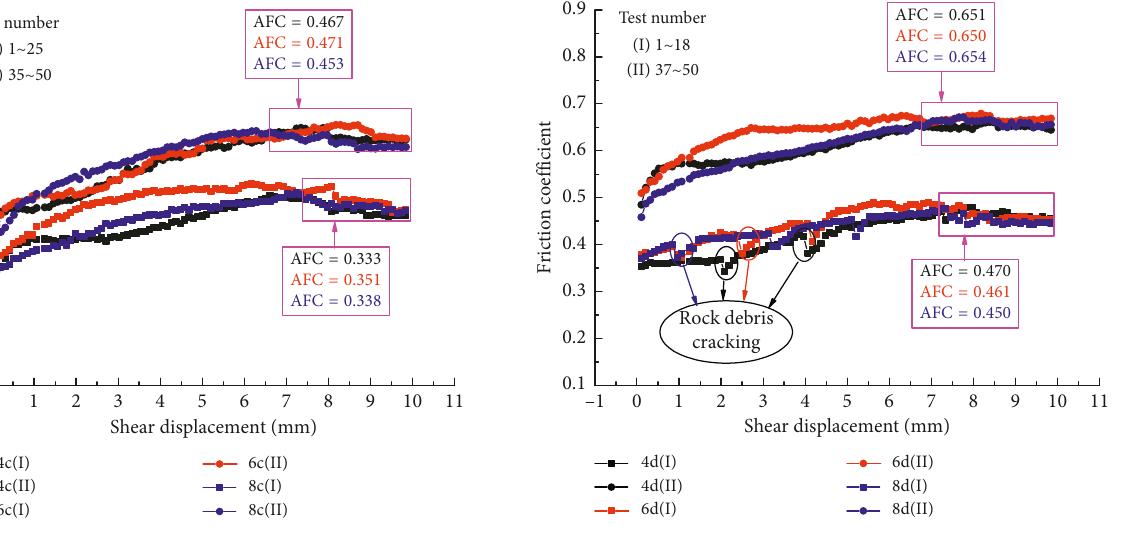
Figure 10: Direct shear testing results under pure bentonite slurry. Figure 11: Direct shear testing results under a mixture of debris and bentonite slurry.